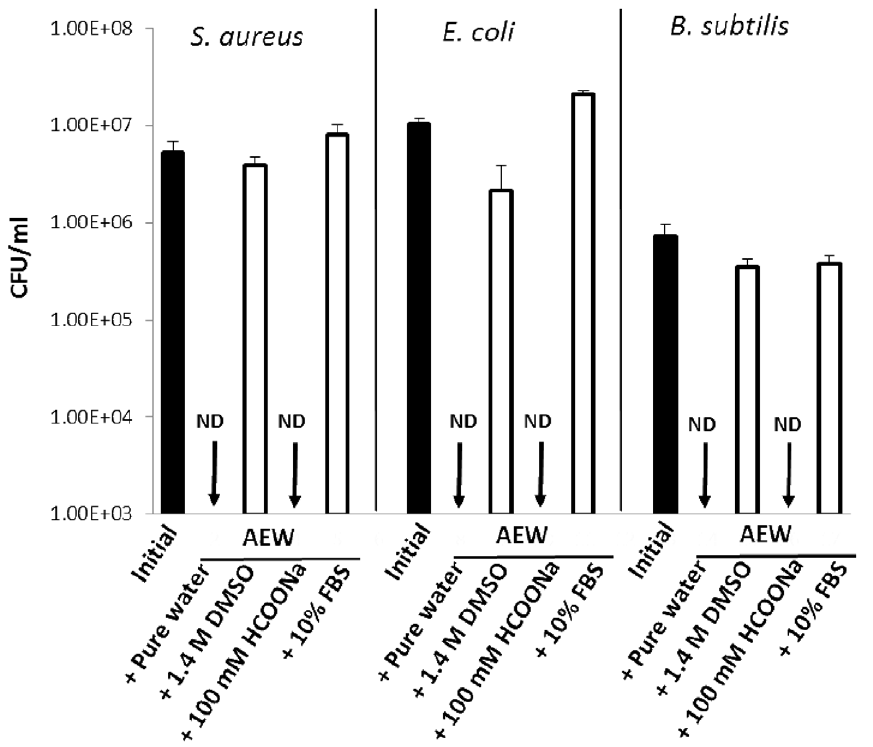
Figure 5. Effects of hydroxyl radical scavengers and fetal bovine serum on AEW bactericidal activity and free available chlorine concentration. DMSO and HCOONa were used as hydroxyl radical scavengers. FBS stands for fetal bovine serum. The AEW was prepared by single electrolysis of 0.1% (w/v) NaCl solution. Each value represents the mean + standard deviation ( n =2 or 3).